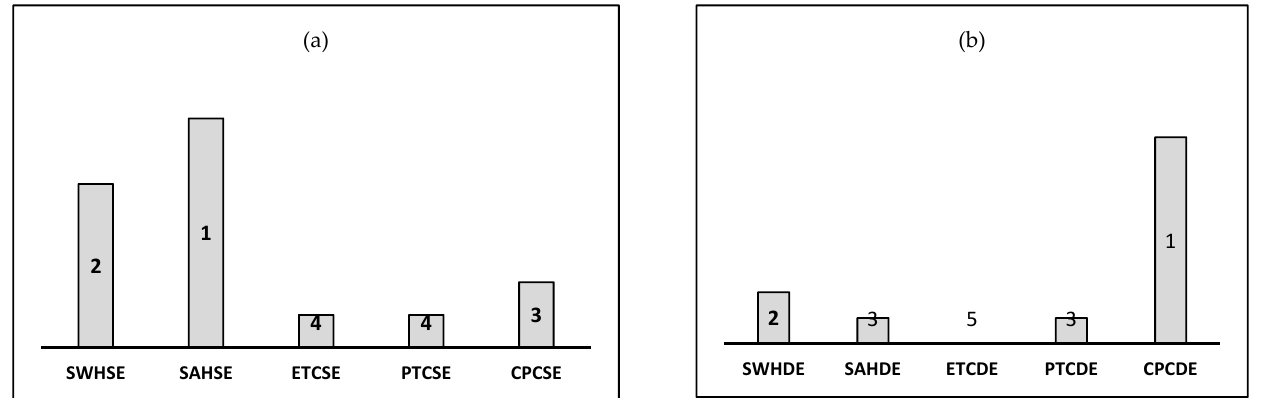
Figure 7. ( a ) Overall Ranking for BWh weather scenario SE, ( b ) Overall Ranking for BWh weather scenario DE.